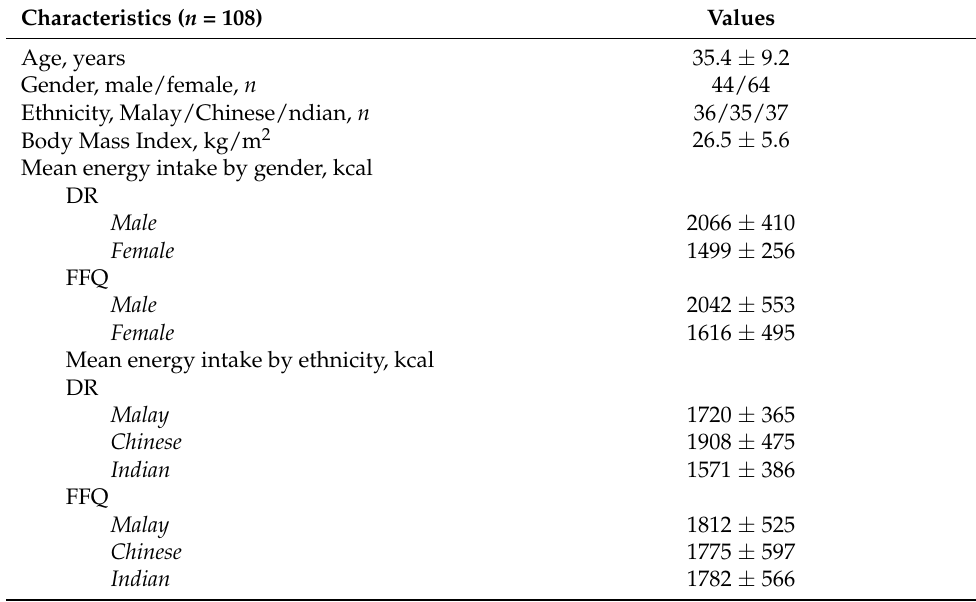
Table 1. Characteristics of subjects.